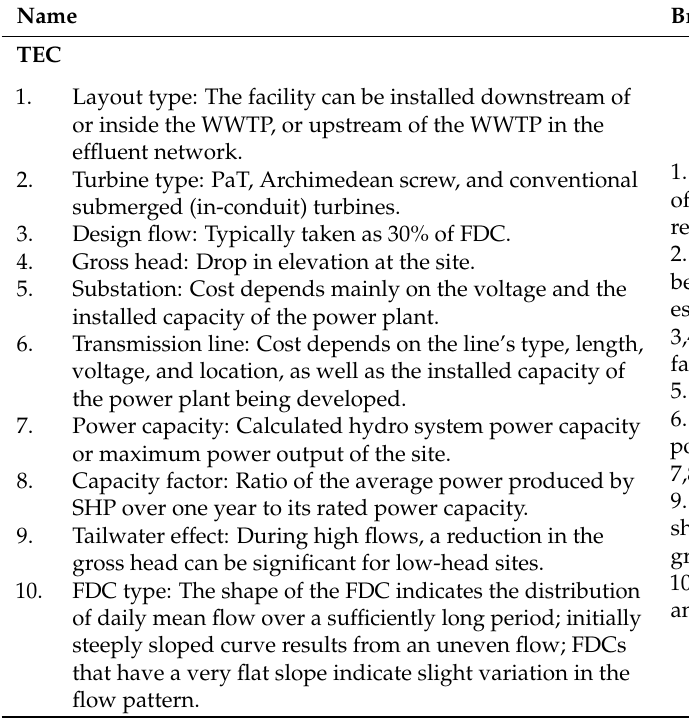
Table 4. Description of the criteria used for MCA (with reference to Table